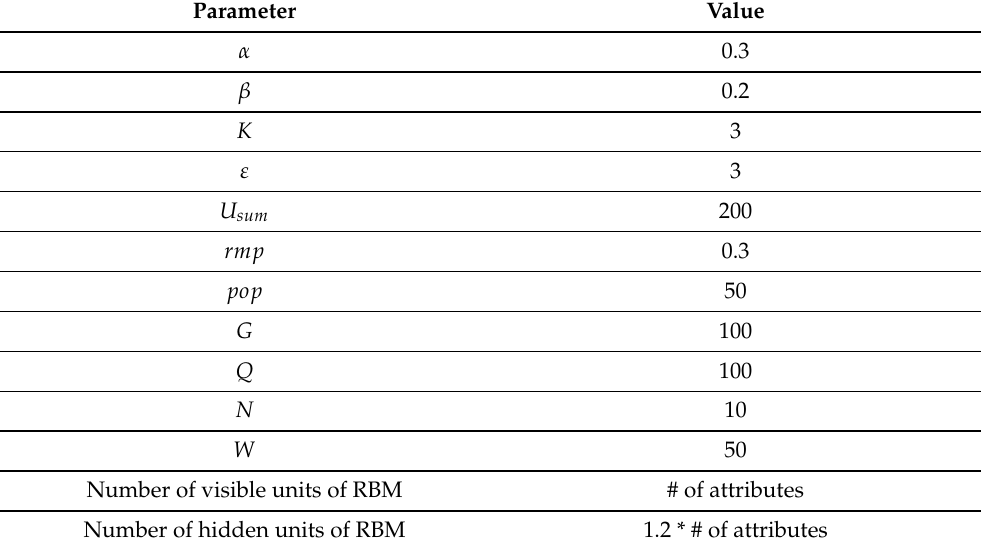
Table 3. Experimental parameters of the proposed algorithm.